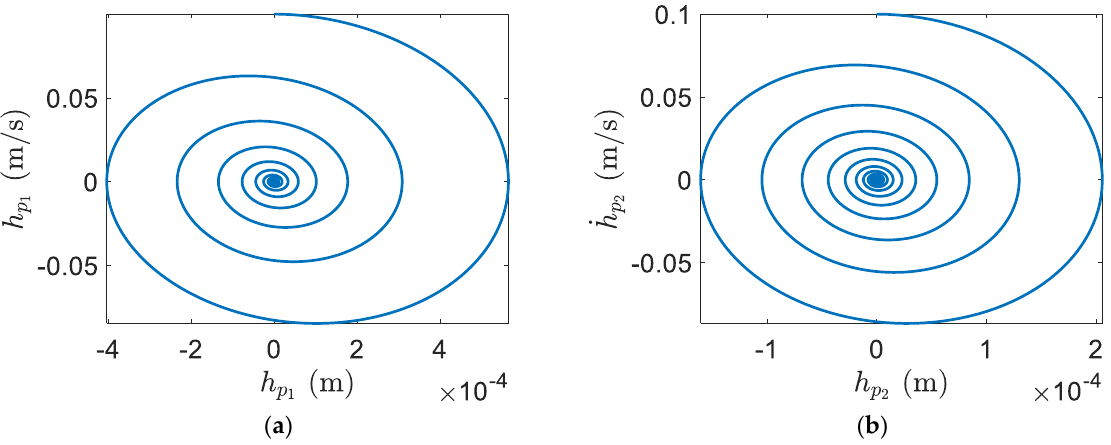
Figure 4. Phase plane for the velocity and the displacement: ( a ) flapwise trajectory; ( b ) edgewise trajectory.